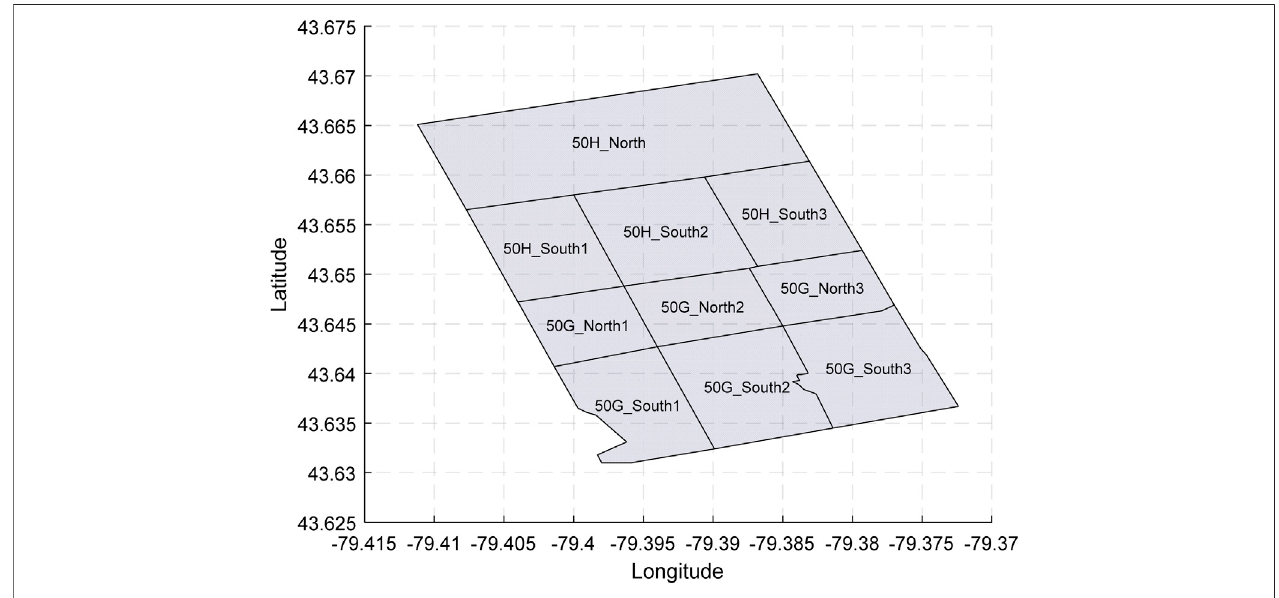
FIGURE 6 | Tile boundaries naming and location.